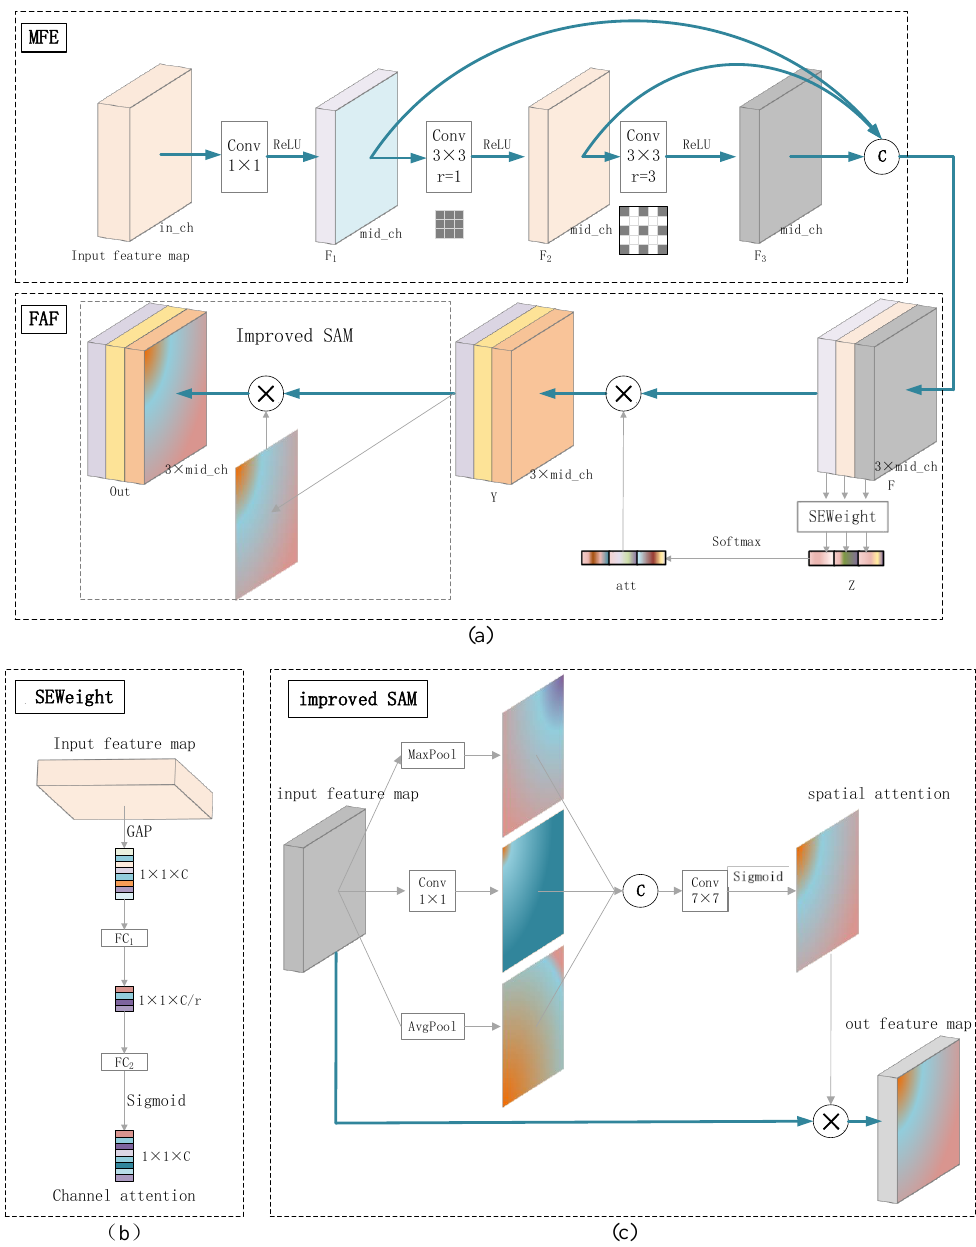
Figure 3. The multi-scale feature adaptive fusion (MFAF). ( a ) The Architecture of MFAF. ( b ) SEWeight, ( c ) The improved